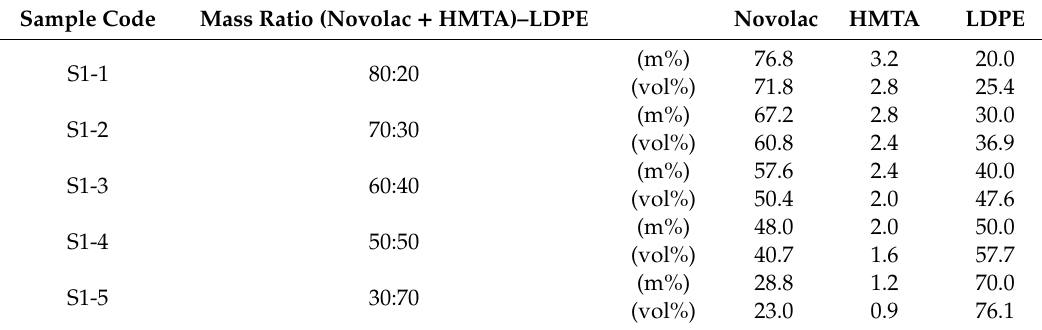
Table 1. List of the formulations prepared for Series 1.